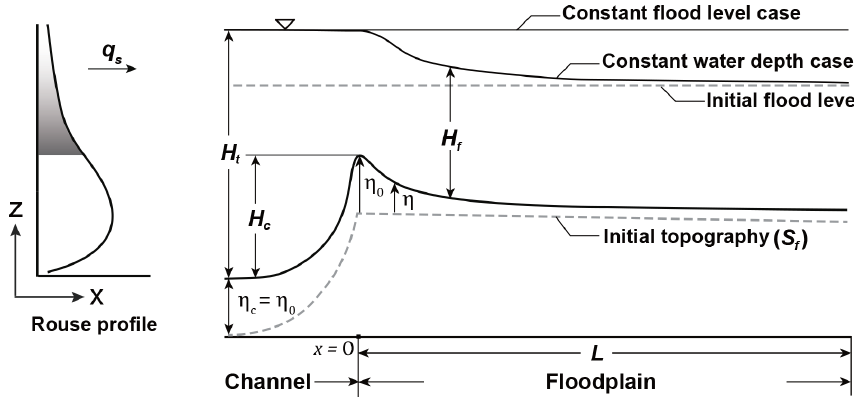
Figure 1. Schematic of a levee with the Rouse profile used in the model. The extent of suspended sediment supplied to the floodplain ( q s ) is gray colored on the Rouse profile. Note that the upstream end of the model is assigned at the channel-floodplain boundary as the origin ( x = 0) where the levee crest develops and the downstream direction of the model is towards the distal floodplain, to which x